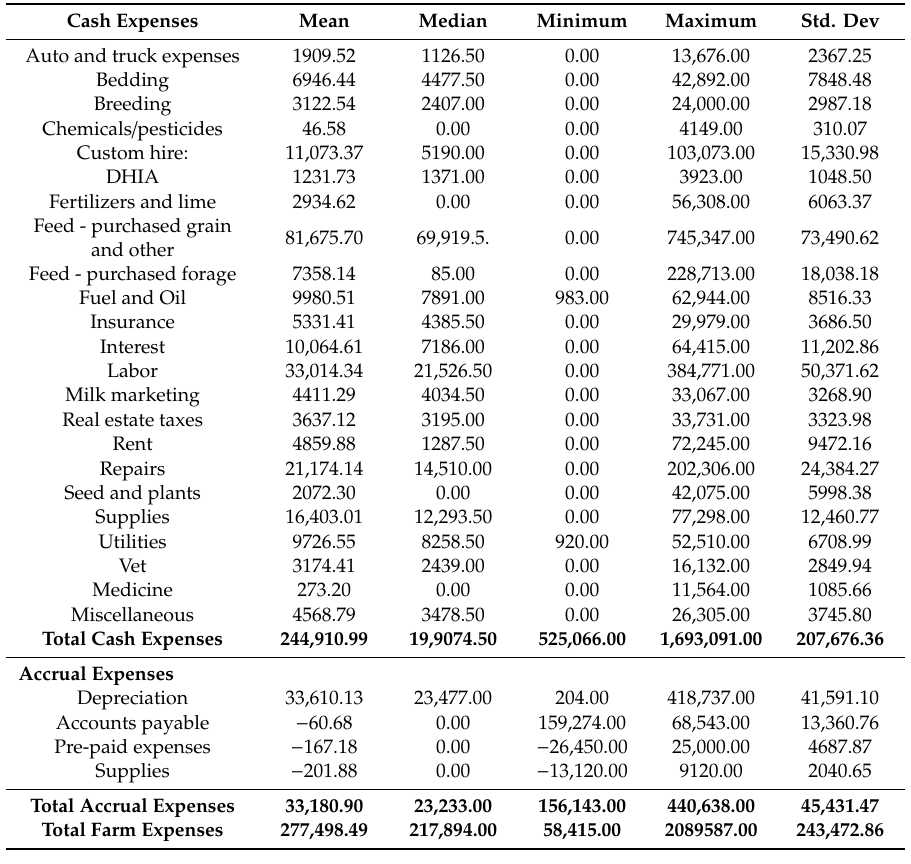
Table A2. Vermont Organic Dairy Expenses (USD) 2006–2016 (n = 392). Not adjusted for